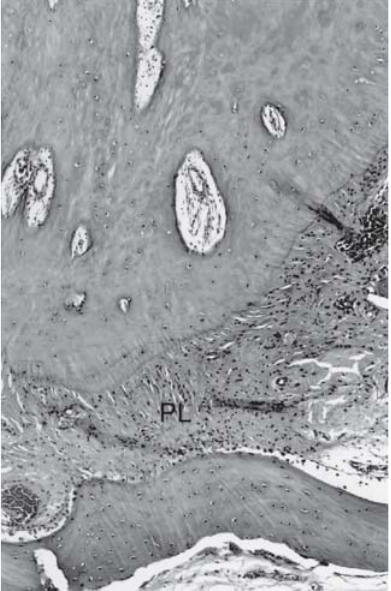
FIGURE 3- Group I (MTA): periodontal ligament in the apical region with normal thickness (PL) and no inflammation. (hematoxylin and eosin - X 40)